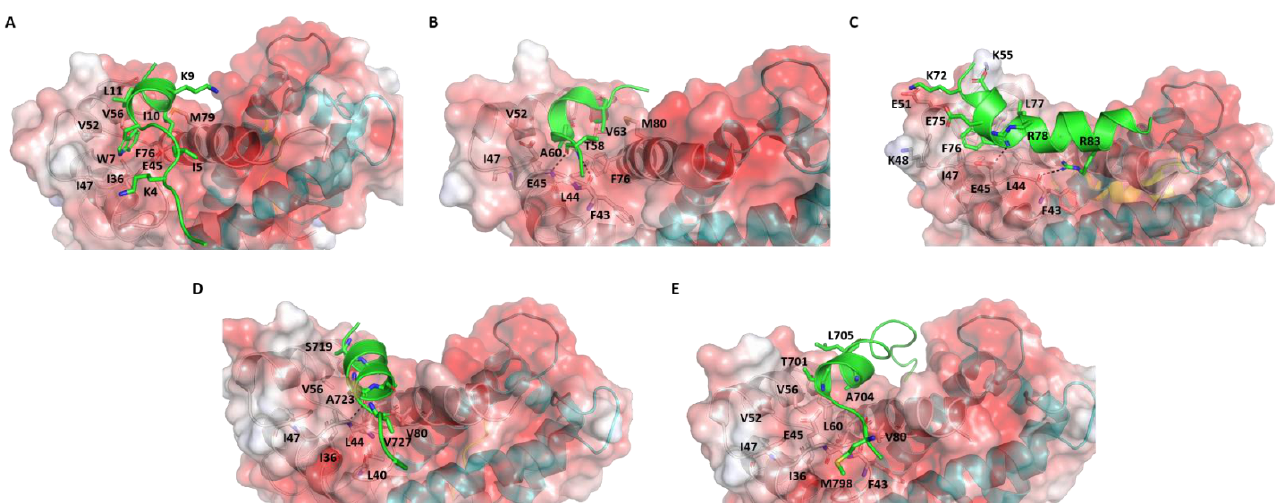
Figure 2. Structures of S100B(ββ)-peptide complexes. Structures of S100B(ββ)—( A ) TRTK12, ( B ) RAGE, ( C ) NDR, ( D ) RSK_PEP2 and ( E ) RSK_PEP1 complexes are shown. The S100B(ββ) protein dimer is shown as an electrostatic surface (red to blue colours represent electrostatic potentials ranging from −5 to +5 kcal/mol) with the two monomers coloured separately (grey, cyan). The bound peptide is shown as cartoon (green) and peptide-protein interacting residues and h-bond interactions are highlighted in sticks and dashed lines, respectively.